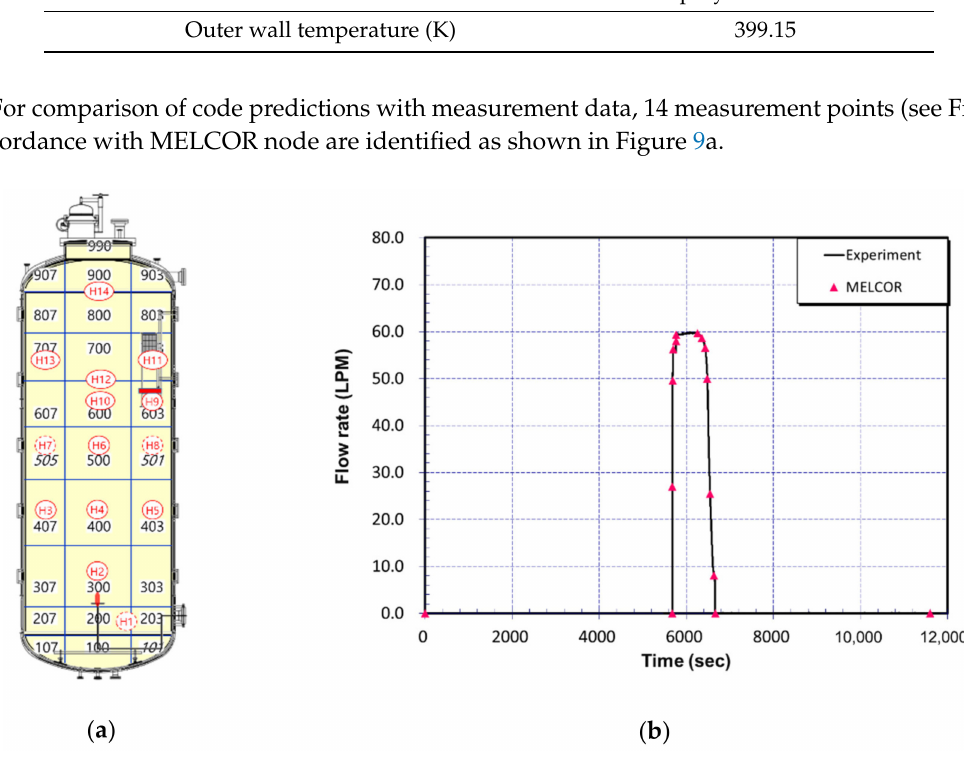
Figure 9. Preparations for comparison of code predictions with test data: ( a ) Measurement locations in accordance with MELCOR node; ( b ) Hydrogen injection flow data applied to MELCOR